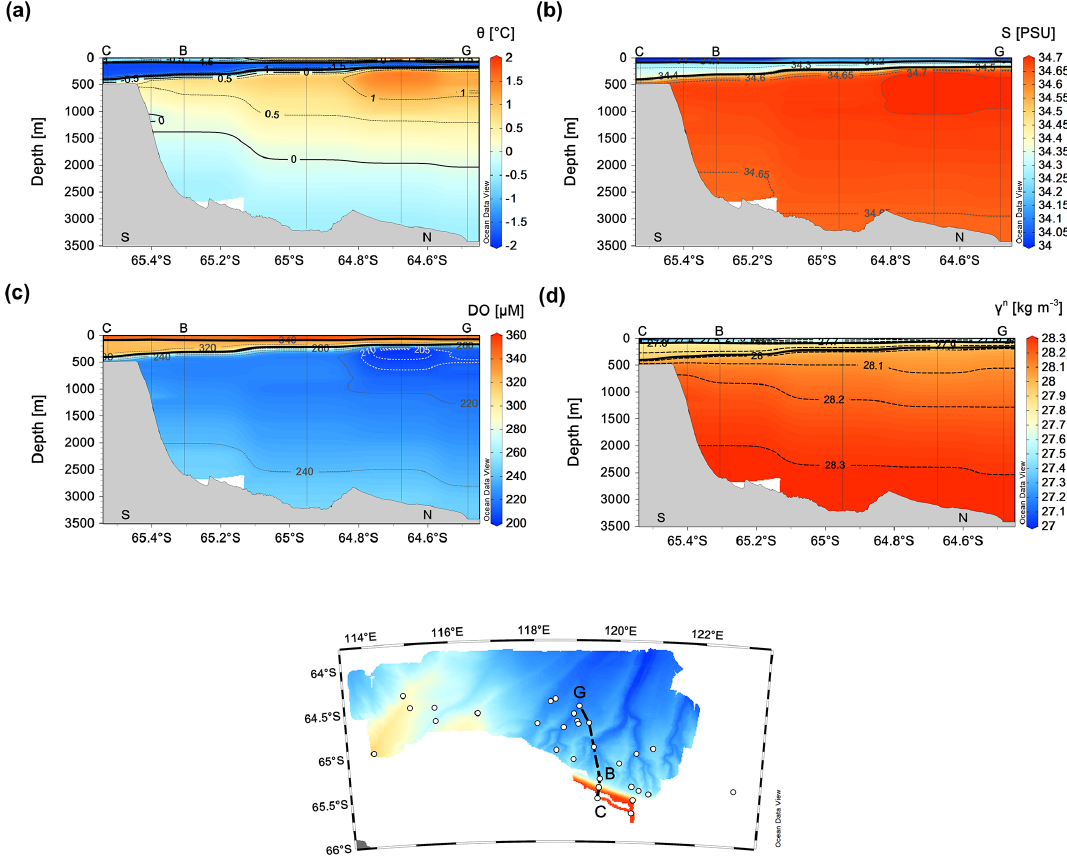
Figure 7. Across-slope transect C–B–G against the geographical latitude. Vertical sections of θ (a) , S (b) , DO concentration (c) , and neutral density (d) over the entire depth range. Isopycnals of 27.55 and 27.70kgm − 3 are shown in all panels (thick black lines), delimiting WW (according to Silvano et al., 2017). See the insert map for the location of the